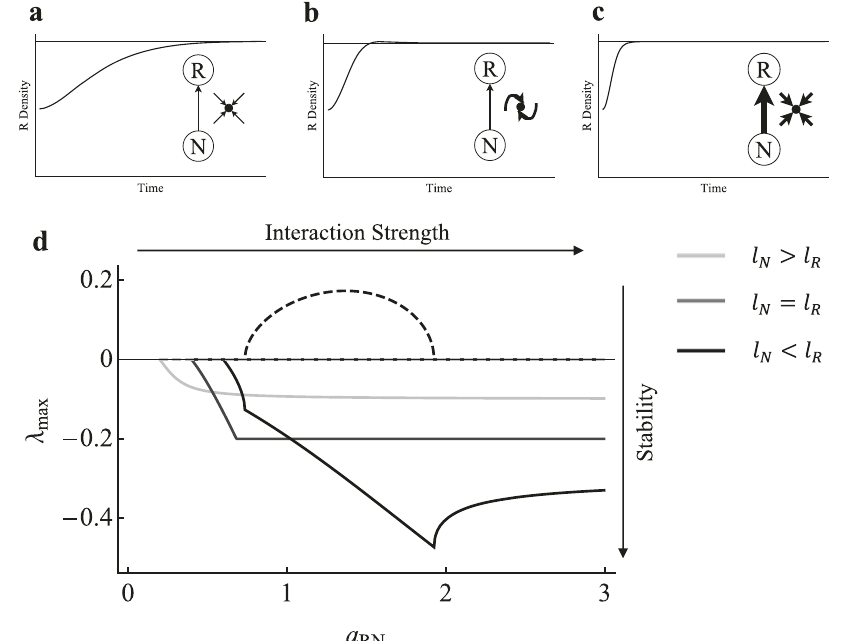
Fig. 4 R – N stability response to increasing interaction strength. Time series showing R density following a perturbation that lowered R density to 50% of equilibrium density for a low ( a RN ¼ 0 : 8), b intermediate ( a RN ¼ 1), and c high maximum rate of nutrient uptake ( a RN ¼ 2 : 8). d Local stability (dominant eigenvalue; λ max ) of the R – N subsystem as a RN is increased for l N > l R , l N ¼ l R , and l N < l R , where l R and l N are the rate at which nutrients are lost to the external environment from compartment R and N, respectively. Solid lines are real parts and dashed lines are complex parts of λ